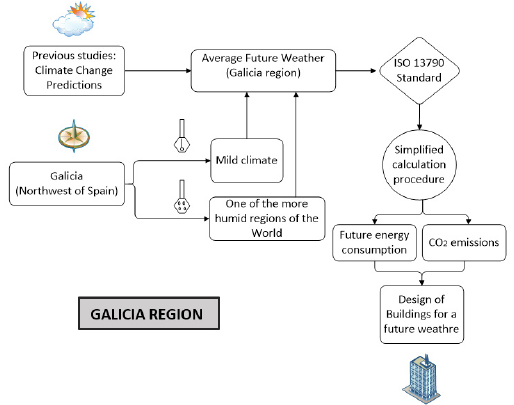
Figure 1. Methodology employed.